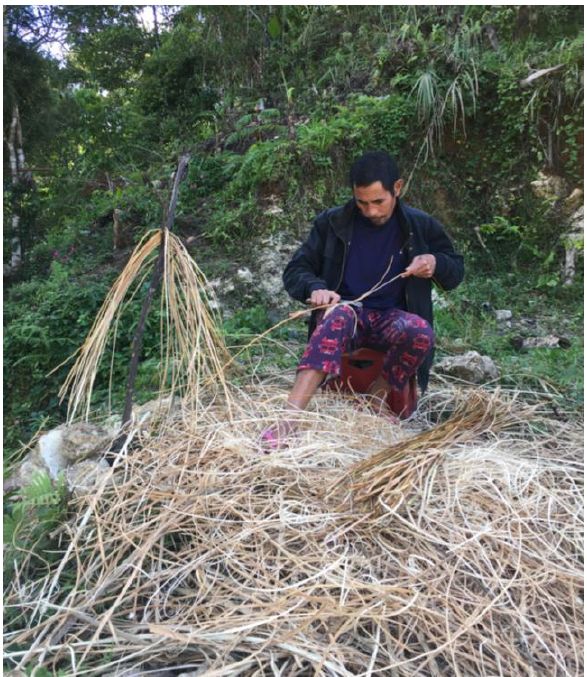
Fig. 5. The process of scraping a native bamboo called “bagtek” which will be used for handicrafts